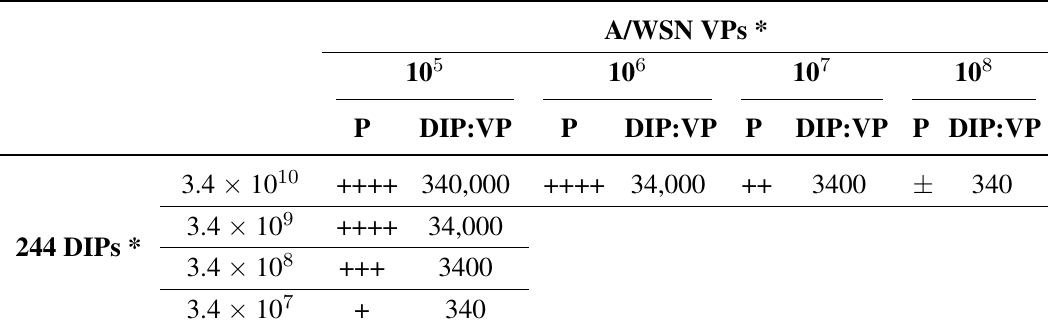
Table 1. Ratios of influenza 244 DI virus particles (DIP): particles of infectious virus (VP), and the protection of mice from challenge with infectious influenza A/WSN